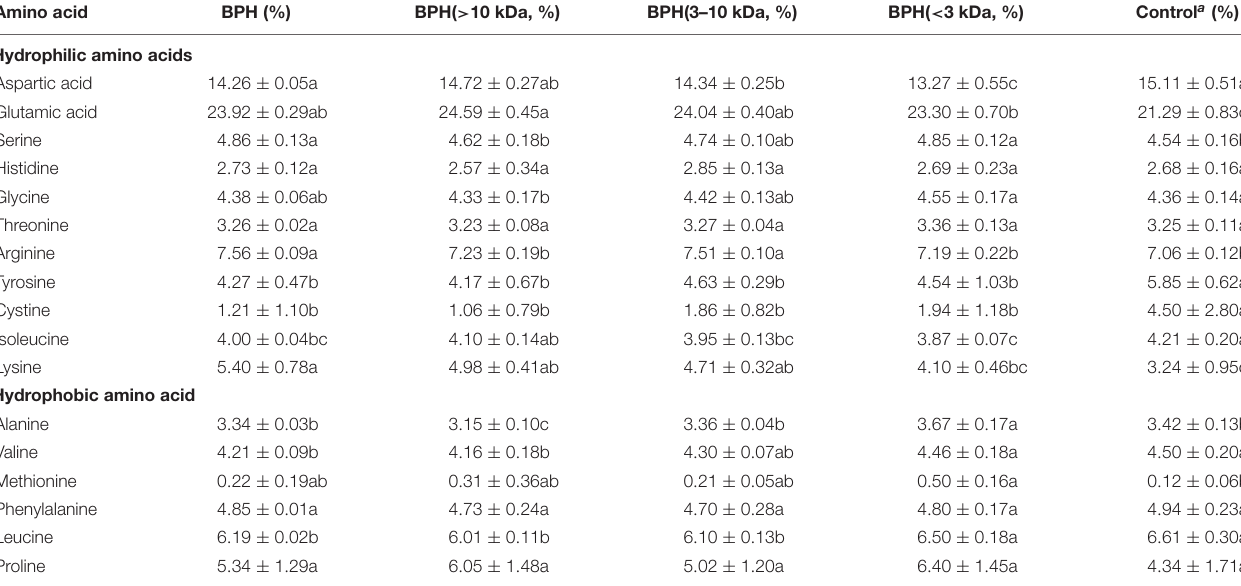
TABLE 2 | Amino acid composition of BPH and its peptide